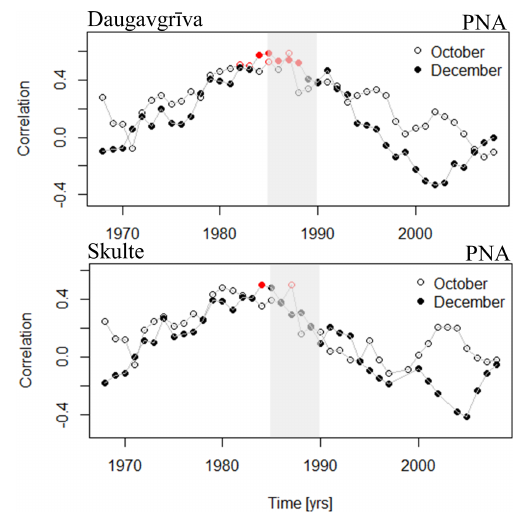
Figure 11. Sliding-correlation results between the water level max- ima in October (open circles) and December (solid circles) with the PNA index. The correlation is calculated using a window of 15 years. The correlation coefficients with a significance of more than 95% are marked in red. The gray rectangle highlights the pe- riod of the abrupt regime